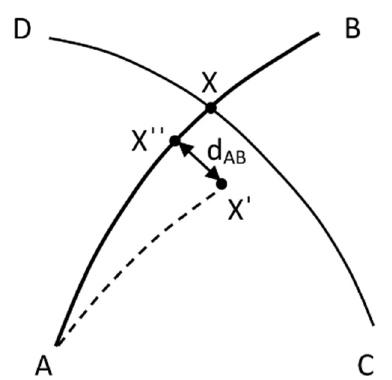
Figure 3. Distance deviation (d AB ) from the geodesic AB. X exact intersection, X’ intersection point calculated by Oracle, Google, ArcGIS, etc., AX’ = Geodesic distance between A and X’, X’’ projection of X’ on the geodesic AB.